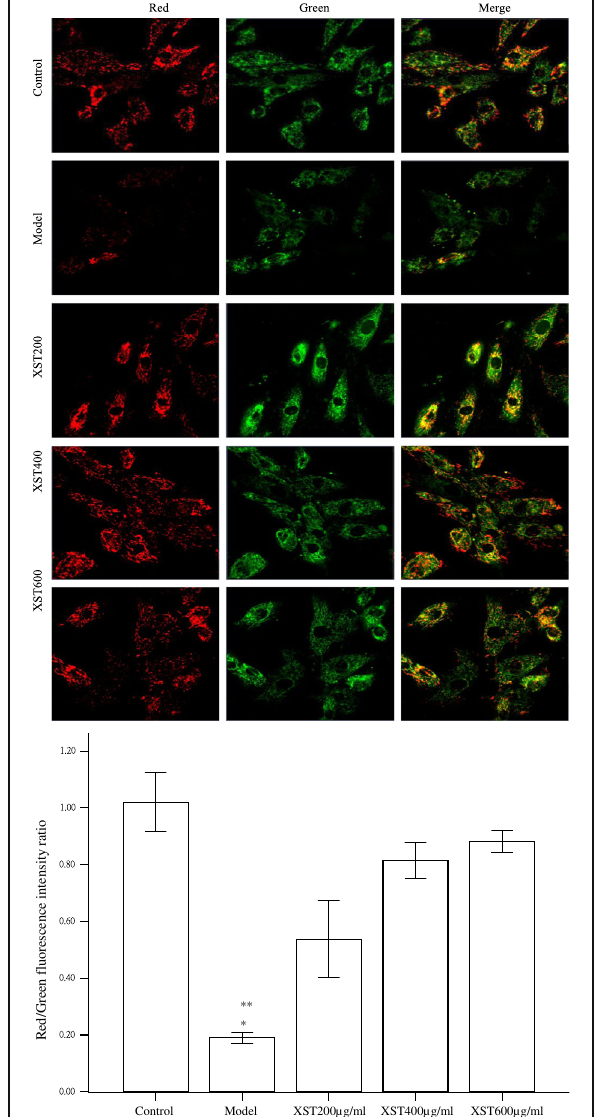
Fig. 3 The mitochondrial Δψ m detected by confocal laser scanning microscopy showed that the intensity of red fluorescence of JC-1 aggregates dropped by more than 80% in the model group compared to the control group. XST dose dependent increase in the red fluorescence was noted, indicating that the drug could restore the loss of mitochondrial Δψ m induced by hypoxia. Morphologically, the cells in the XST-treated groups were more regular in size and shape than those in the model group (× 400). Bar graphs showed that the red/green fluorescence intensity ratio increased in a XST dose dependent manner. All samples were checked in three independent experiments with three replicates each. Data are represented as the mean ± SD ( * P <0.05 vs. XST 200, 400 or 600 μ g/ ml, ** P <0.001 vs. the control